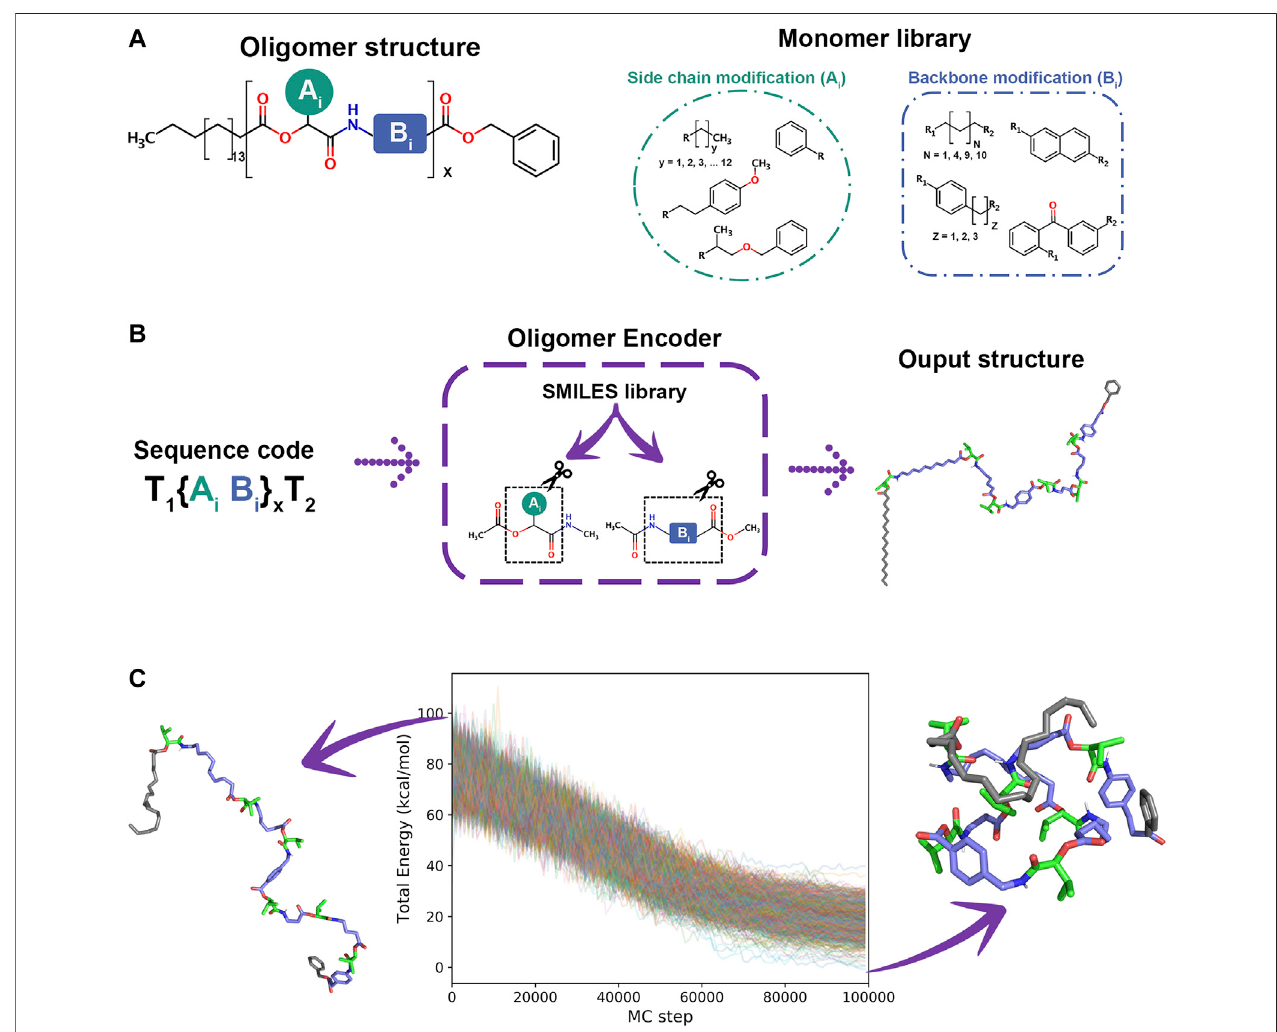
FIGURE11|(A) OligomerstructureandmonomerLibrary (B) .OEwork fl ow (C) Foldedandunfoldedstructureofoligomersequenceandenergyconvergedduring 1000 MC annealing simulations from 900 to 100